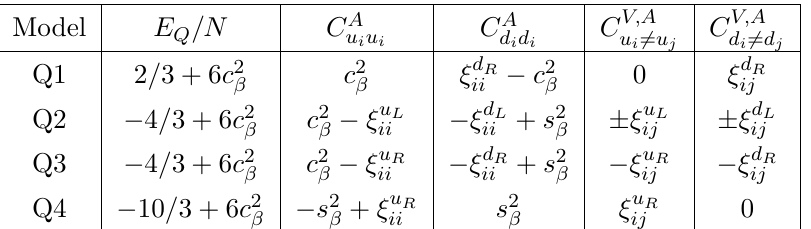
Table 1 . Axion couplings in the four “nucleophobic” models Q1-Q4, see eq. (2.9), as a function of the parameters ξ q P and c β ≡ cos β, s β ≡ sin β . Here E Q denotes the contribution of the quark sector ij to the electromagnetic anomaly coefficient E , to be added to the contribution from the charged lepton sector. In all models the domain wall number is trivial, 2 N = 1 .